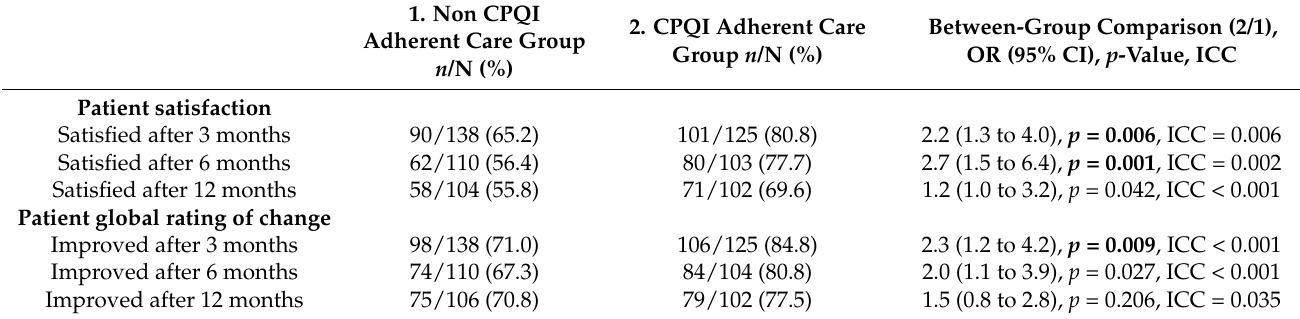
Improved after 12